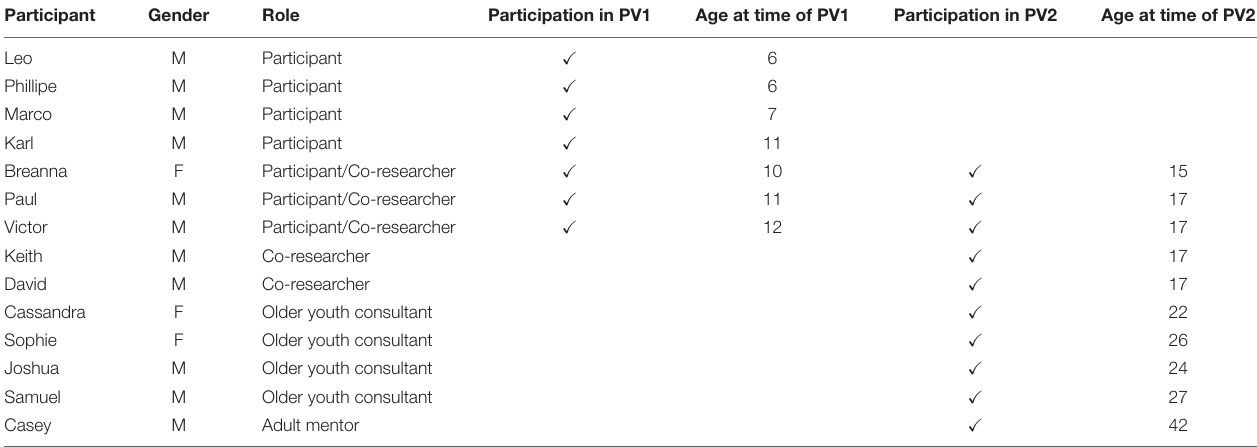
TABLE 1 | Recruitment results for PV1 and PV2.